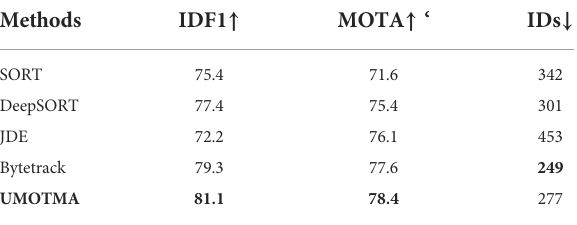
TABLE 2 Comparison of the methods on the underwater fi sh school test set.